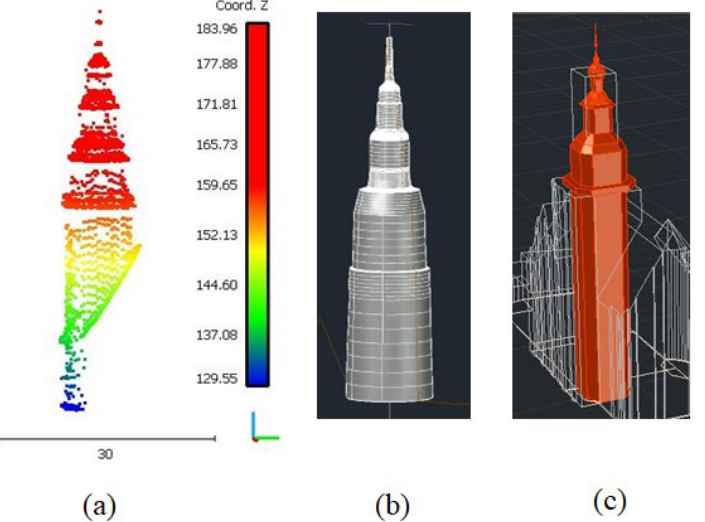
Figure 2. Tower of the Olsztyn City Hall building; ( a ) LiDAR point cloud; ( b ) Model 1 generated directly from a point cloud; ( c ) Model 2 generated from the point cloud and the terrestrial image shown in Figure 1b.